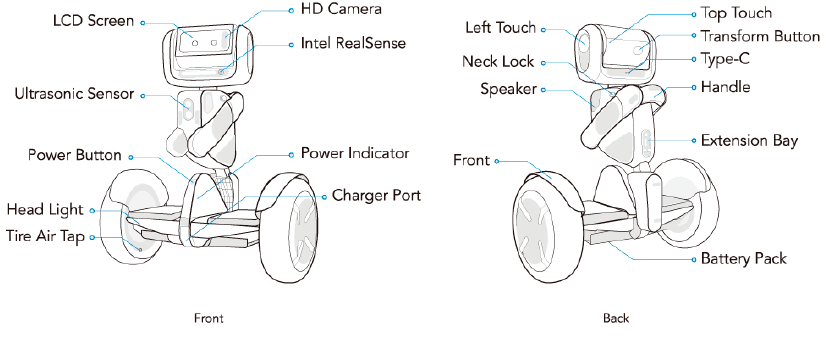
Figure 3. Loomo robot components